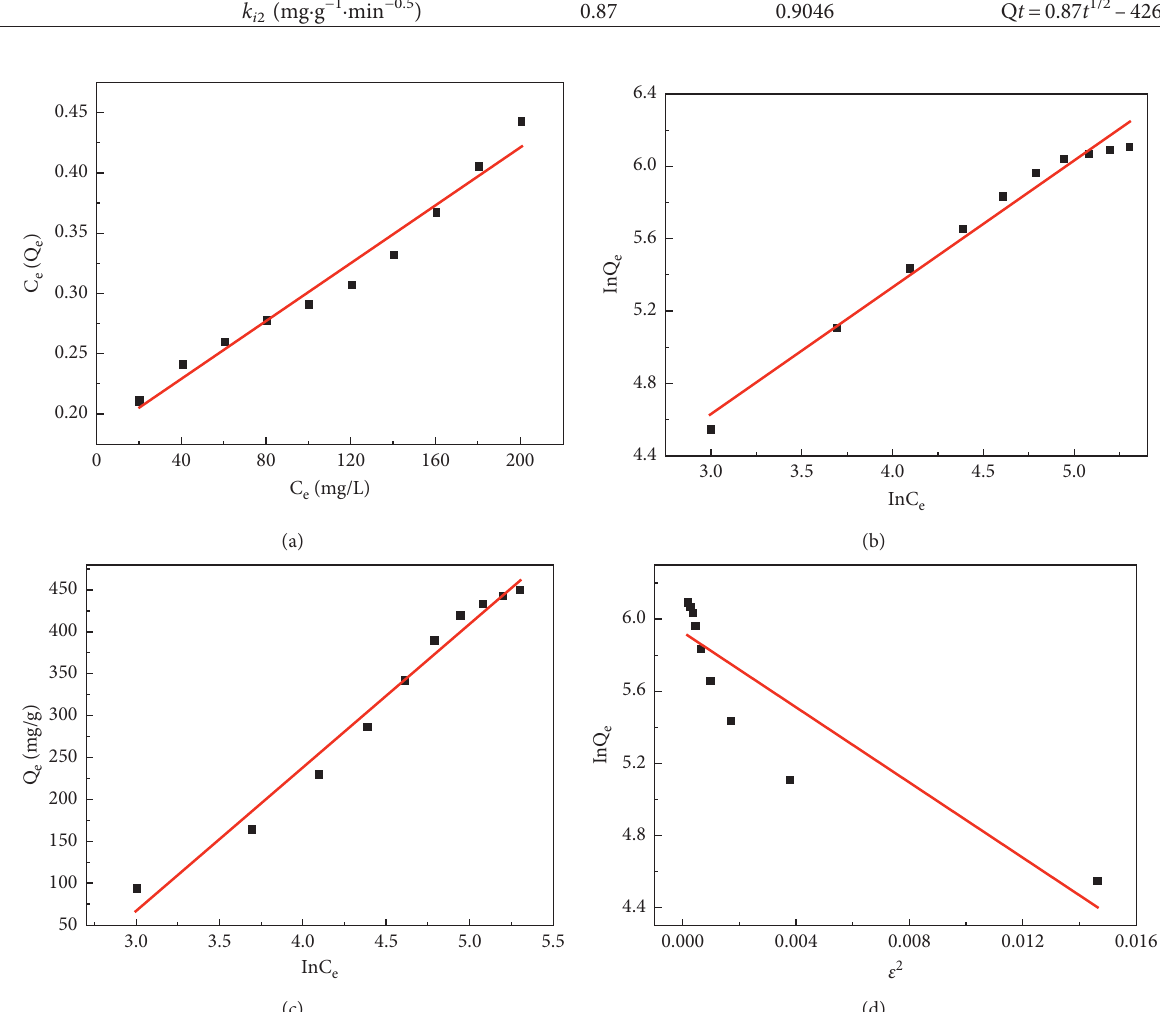
Figure 13: Cr(VI) adsorption on Fe 3 O 4 /PPy nanotubes described by (a) Langmuir, (b) Freundlich, (c) Temkin, and (d) Dubi- nin–Radushkevich isotherm adsorption